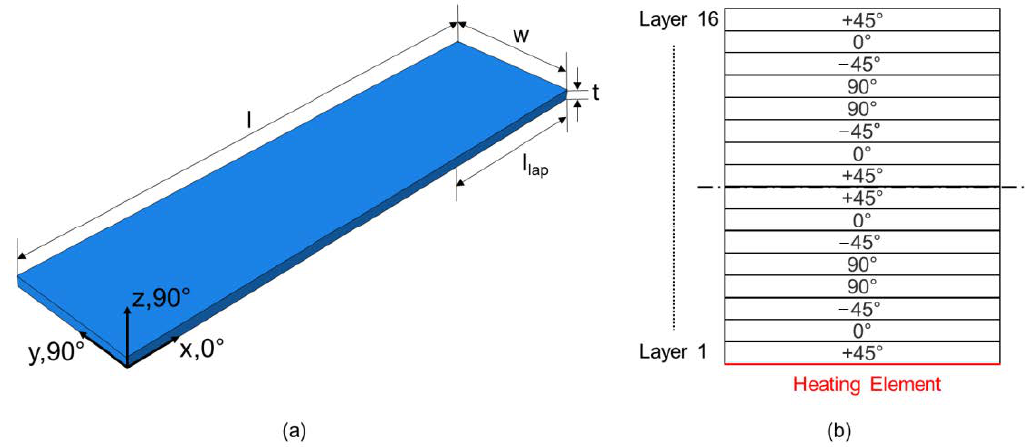
Figure 2. ( a ) Definition of geometry and used coordinate systems; ( b ) Layup with z-direction as axis of rotation.